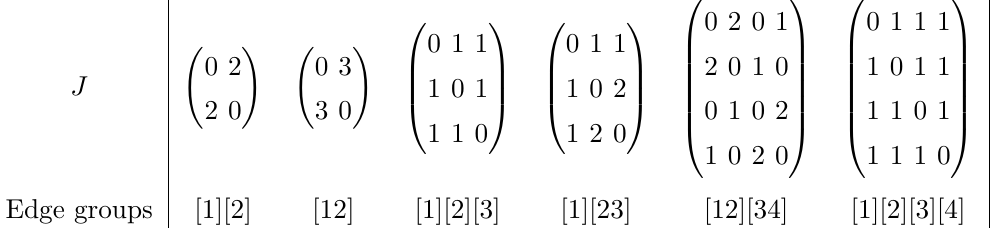
Table 2 . Edge-adjacency matrices and the corresponding Wick-edge groups for periodic cases. Open